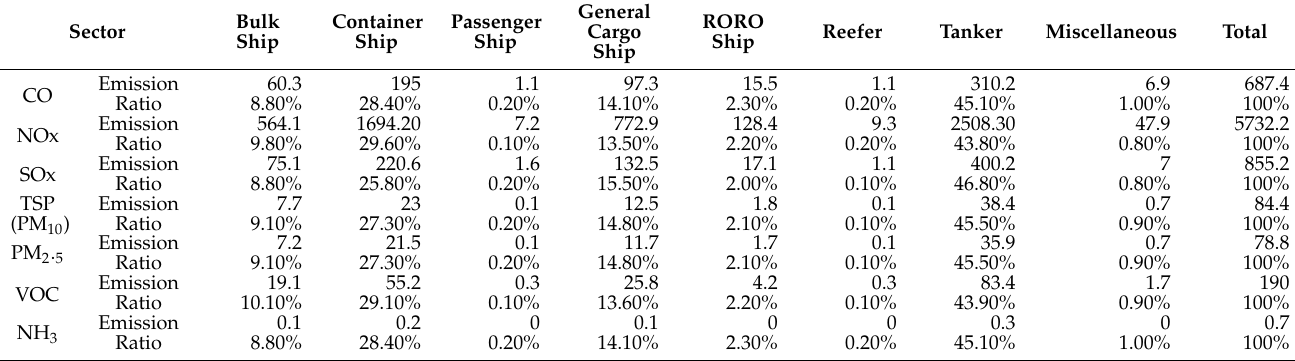
Table 7. Air pollutant emissions by ship